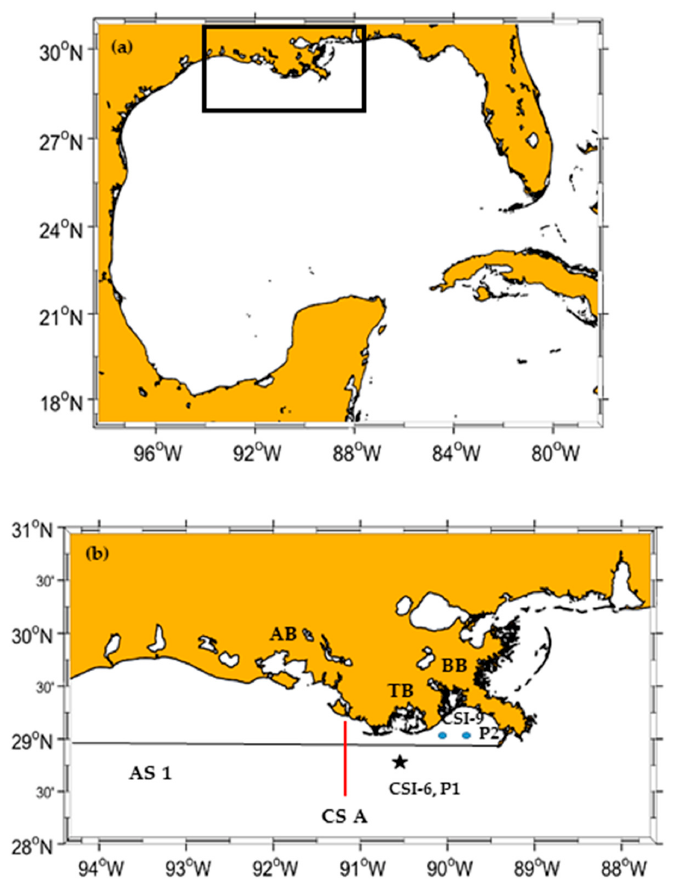
Figure 1. ( a ) Location of the Louisiana shelf (the black box) in the northern Gulf of Mexico, ( b ) A close view of the Louisiana shelf geographical extent. The horizontal black line (LS 1) is the along-shelf section later used to examine the simulated temperatures across the water column. The red north–south line is the cross-section A used to represent temperature results across the water column. The location of station CSI-6 used for evaluation of the hydrodynamics model is shown by